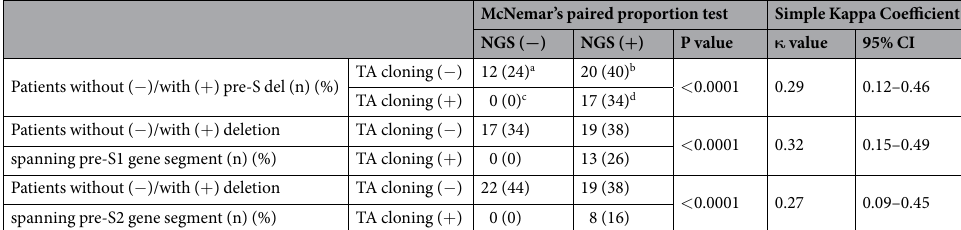
Table 3. Comparison of the pre-S genotyping results by TA cloning- and NGS-based analyses in 49 HBV- related HCC patients. a The number of patients without the indicated pre-S deletion by both TA cloning- and NGS-based analyses. b The number of patients with the indicated pre-S deletion by NGS- but not TA cloning- based analysis. c The number of patients with the indicated pre-S deletion by TA cloning- but not NGS-based analysis. d The number of patients with the indicated pre-S deletion by both TA cloning- and NGS-based analyses. Abbreviations: n,